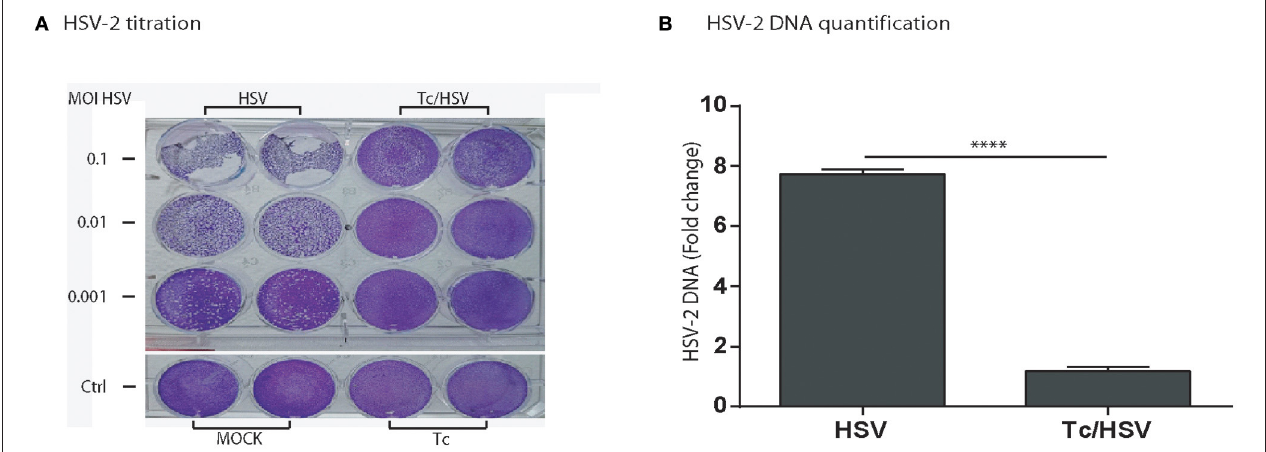
FIGURE 8 | Trypanosoma cruzi infection impairs herpes simplex type-2 (HSV-2) replication. (A) HSV-2 titration by plaque-forming-units assay in Vero cells showing plaques developed by HSV-2 (G-strain) in Vero cell cultures 48 h after viral monoinfection (columns identified as “HSV”), or parasite + viral coinfection (columns identified as “Tc/HSV”) and stained with crystal violet, as described in Section Materials and Methods. Each line represents an HSV-2 inoculum or multiplicity of infection –m.o.i- (0.1; 0.01; 0.001). “Ctrl”: Non-infected cells (“MOCK”) and T. cruzi mono-infected cells (“Tc”). (B) Fold-change in HSV-2 DNA between HSV-2 monoinfection, and Tc/HSV-2 coinfection. Two-tailed paired Student t -test P -values indicate statistical significance (*** P <